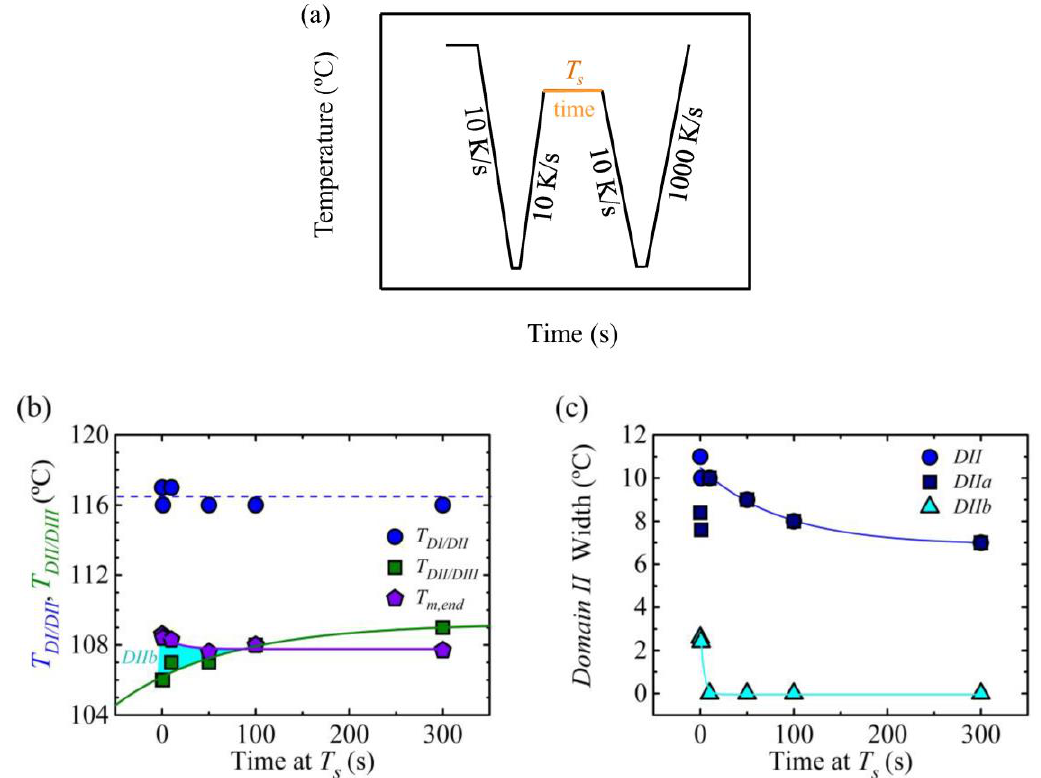
Figure 4. ( a ) Thermal procedure employed for varying the time spent at T s , keeping the sample at about 160 ◦ C for 30 s to erase completely the thermal history, and cooling down to − 50 ◦ C, the sample is kept at this temperature, − 50 ◦ C, for 0.1 s, ( b ) transition temperature between Domains and temperature corresponding to the end of the melting endotherm ( T m,end ) and ( c ) width of Domain II as a function of time spent at T s .